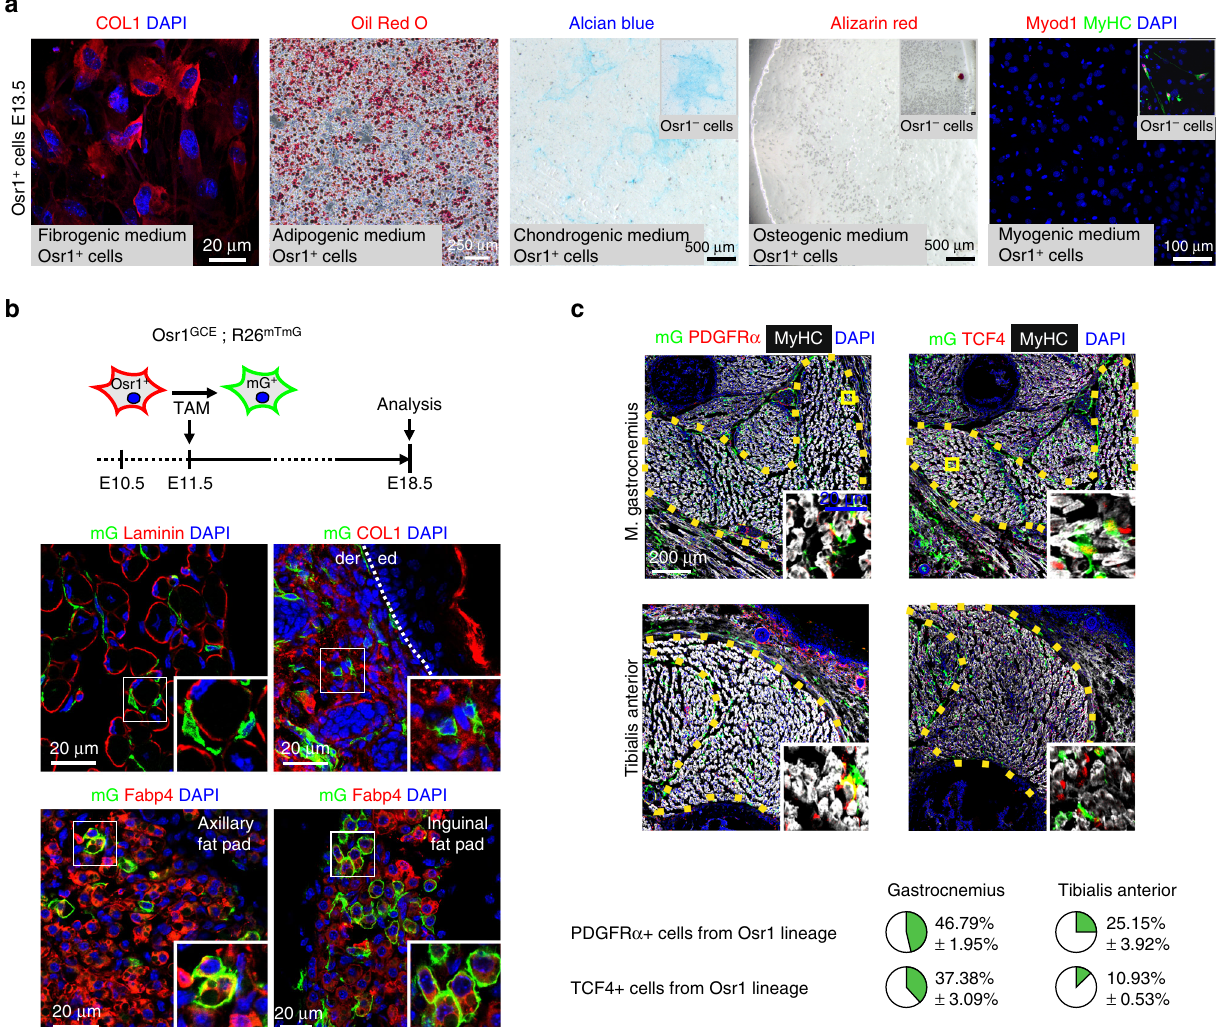
Fig. 3 Osr1 + cells are embryonic fi bro-adipogenic progenitors. a Cultures of Osr1 + cells under fi brogenic, adipogenic, chondrogenic, osteogenic or myogenic conditions. Fibrogenic differentiation was assessed by COL1 immunolabelling, cells exhibited stretched myo fi broblast morphology. Adipogenic differentiation was assessed by Oil Red O staining, chondrogenic and osteogenic differentiation was assessed by Alcian blue and Alizarin red staining, respectively and myogenic differentiation was tested by immunolabelling for Myod1 and MyHC. Osr1 + cells show fi brogenic and adipogenic differentiation, but no osteogenic or myogenic differentiation. GFP − FACS-sorted cells (Osr1 − ) containing osteo-chondrogenic and myogenic progenitors were used as controls (inserts). b Osr1 cell lineage tracing in E18.5 Osr1 GCE/ + ; R26R mTmG/ + embryos after Tamoxifen induction at E11.5. Membrane eGFP (mG) positive cells represent Osr1 + cell progeny. Schematic depiction of Osr1 GCE/ + ; R26R mTmG/ + -based lineage tracing during development is shown above. Osr1 + progenitors give rise to muscle interstitial cells, dermis cells embedded in Collagen type I-rich matrix, and adipocytes immunolabelled for Fatty acid binding protein 4 (FABP4) in axillary and inguinal white fat pads. Ed = epidermis, der = dermis. c Osr1 cell lineage tracing in E18.5 Osr1 GCE/ + ; R26R mTmG/ + embryos after Tamoxifen induction at E11.5 as in b . Lineage contribution of Osr1 descendants (mG + ) to PDGFR α and Tcf4 cells was analysed in the gastrocnemius and tibialis anterior muscles. Quanti fi cation is shown below ( n = 3). Values represent mean ± s.e.m. N-numbers indicate biological replicates, i.e. samples from different